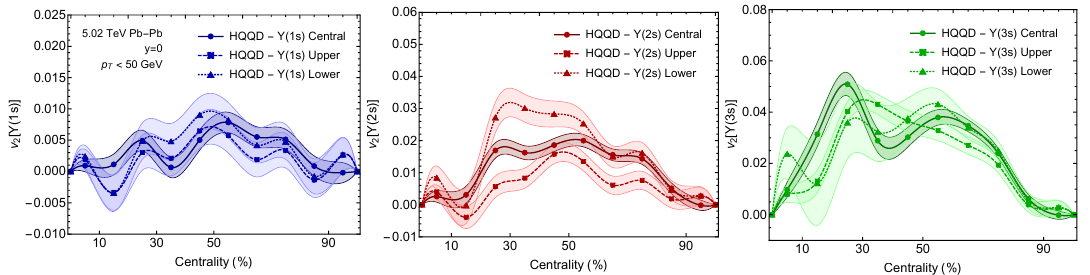
Figure 5 . Elliptic flow for s -wave bottomonium states as a function of centrality. Solid lines and bands show spline-interpolated results for the mean and statistical uncertainty of the mean obtained from HQQD.The upper (squares), central (circles), and lower (triangles) indicate the variation of the HQQD result when changing the model parameters in the range specified in eq. (6.1). Points show results obtained in equally spaced bins of 10% centrality from